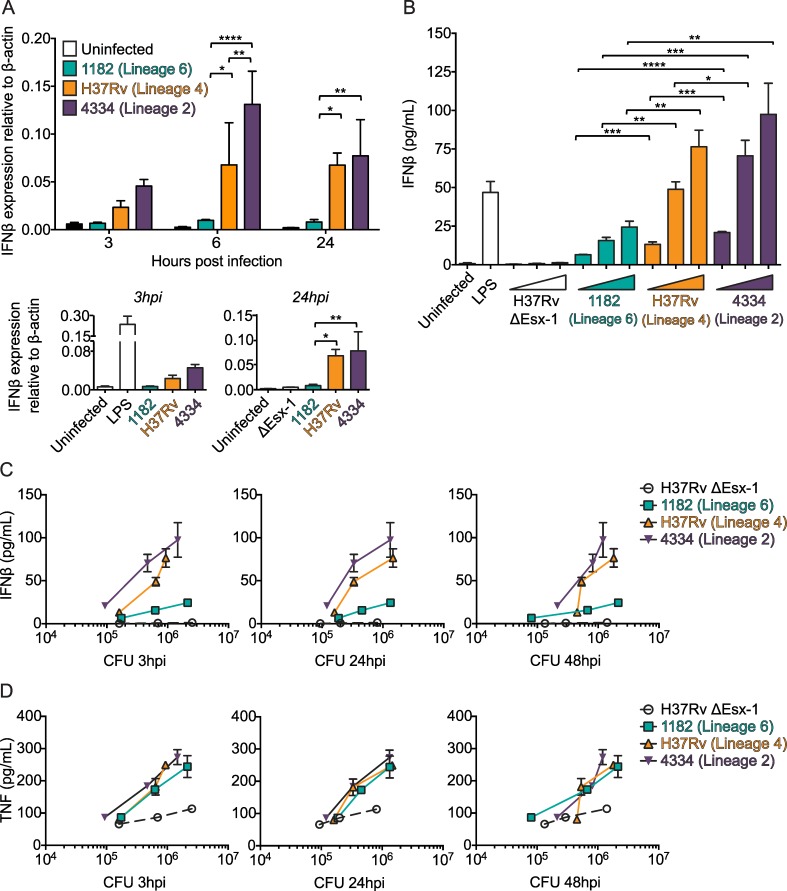
IFNβ induction is bacterial strain-dependent during Mtb infection.A) BMDM were infected with the indicated mycobacterial strains at an MOI of 5 or stimulated with LPS (10 ng/mL). RNA was harvested for IFNβ mRNA quantification by qRT-PCR at 3, 6, and 24 hr post infection. *p<0.05, **p<0.01, ****p<0.0001 by two-way repeated measures ANOVA with Tukey post-tests; means ± SD (n = 3). B) BMDM were infected with the indicated bacterial strains at MOI of 1, 5, and 10 or stimulated with LPS (10 ng/mL). Supernatants were collected for IFNβ protein quantification by ELISA at 48 hr post infection. *p<0.05, **p<0.01, ***p<0.001, ****p<0.0001 by one-way ANOVA with Tukey post-tests for each MOI; means ± SD (n = 3). Results are representative of 3 independent experiments. C-D) Cell lysates from the experiment shown in Fig 1B were collected at 3, 24, and 48 hr post infection. Colony forming units (CFU) were quantified by serial dilution on 7H11 agar plates. CFU for each MOI at each time point are plotted on the x-axes and the corresponding IFNβ (C) and TNF (D) secretion at 48 hr post infection is plotted on the y-axes.